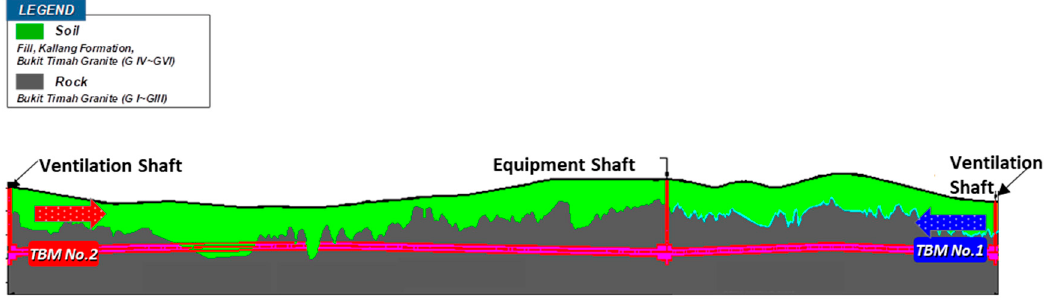
Figure 2. Geological conditions along the tunnel alignment. Table 1. Geomechanical characteristics of Bukit Timah granite.